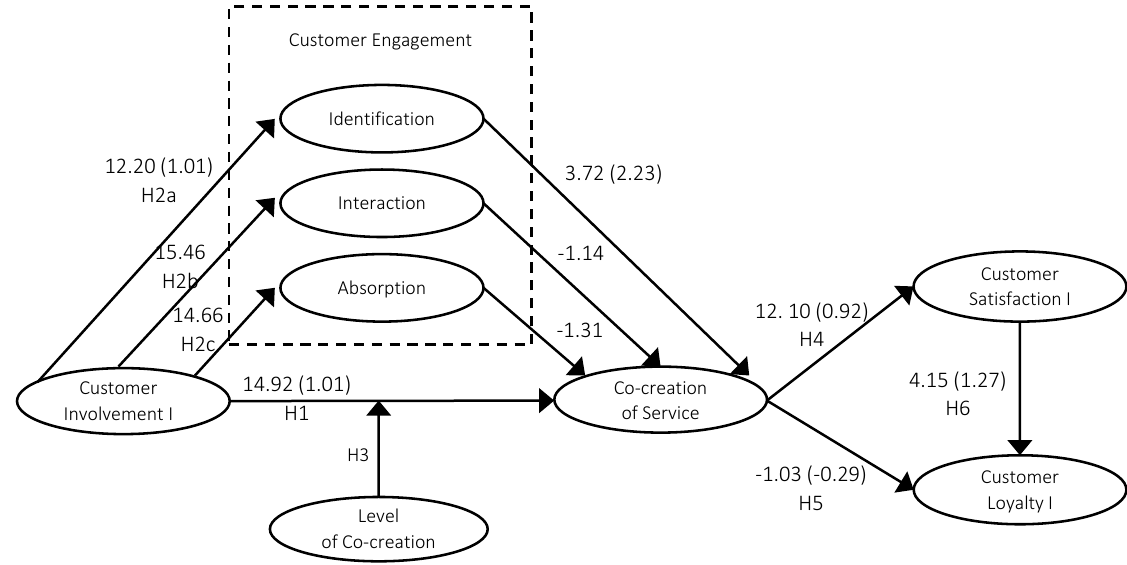
Figure 2. Research model with